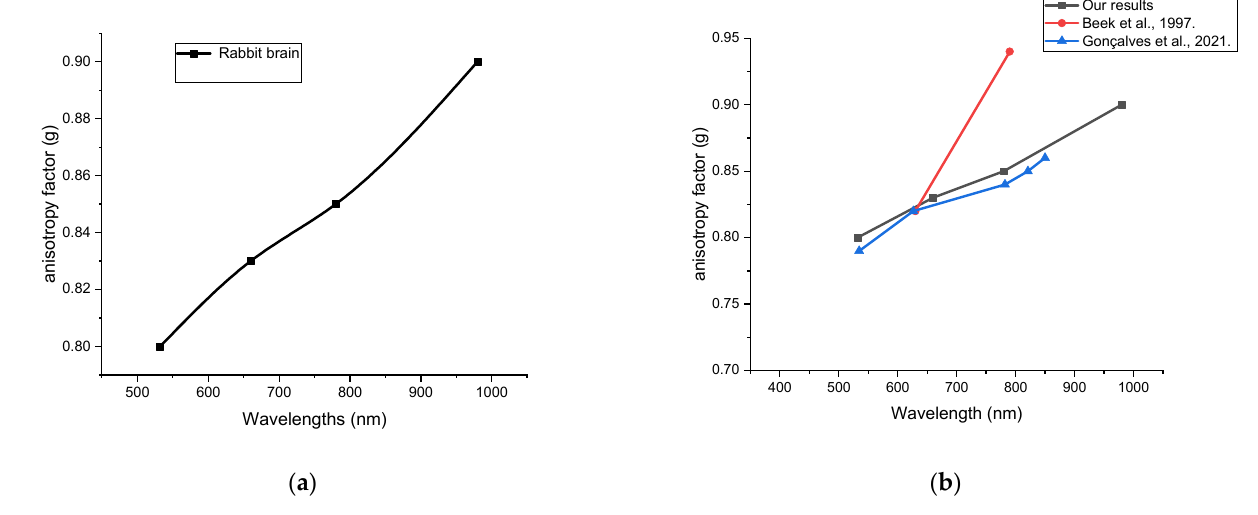
Figure 12. Anisotropy factor was measured ( a ) in rabbit brain tissue and ( b ) compared our data with data from the literature, there was a difference between this and the variance factor measured for Beek et al. [36] In contrast with Gonçalves et al. [29], which was closer to our measurements. In the present study, ex vivo optical parameters of the rabbit skin, skull, and brain were determined and compared with data from the literature (Figure 13). The parameters were obtained for four laser wavelengths ranging from visible to NIR optical regions. The proposed results showed similarly reduced scattering coefficients of the skull at 532 nm to that published by Soleimanzad et al. [34] for mice skull, and Firbank et al. [35] for pig skull at 660 and 780 nm, while there were some differences in the absorption coefficient values. Regarding the skin samples, the optical parameters obtained at 660 were a little higher than at 780 nm, which followed almost the same behavior compared with those obtained by Beek et al. [36] at 630 and 790 nm. Moreover, the obtained optical parameters of the rabbit brain were comparable to those obtained by Pitzschke et al. [37] at near wavelengths with some variations within the acceptable range. In principle, the sample preparation method, sample thickness, experimental technique, and the employed mathematical model could be reasons for the relatively spread values for µ a and µ (cid:48) in the literature [38].